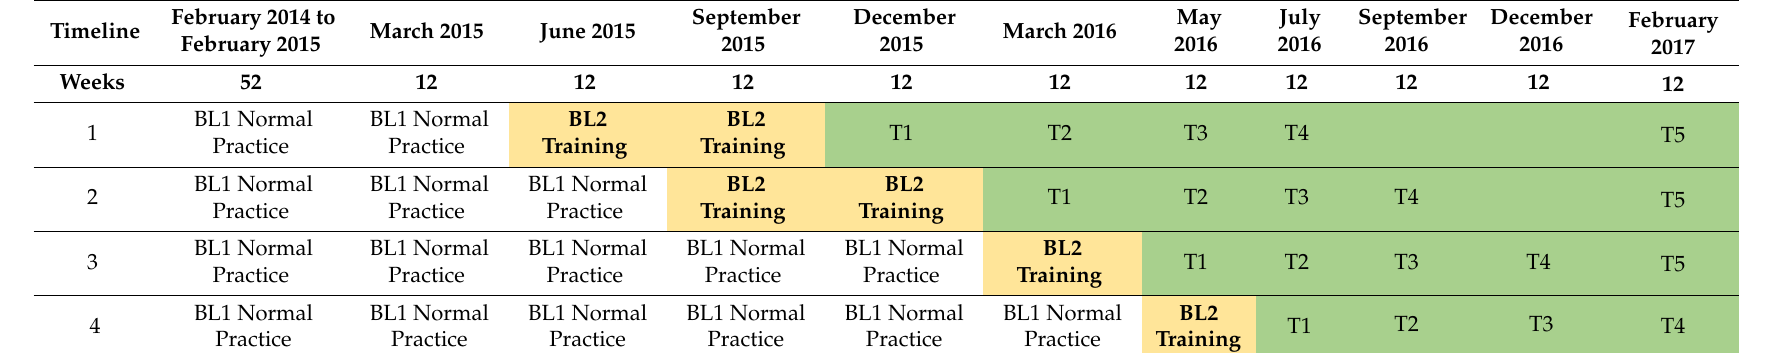
Table 1. Stepped-Wedge Timeline.